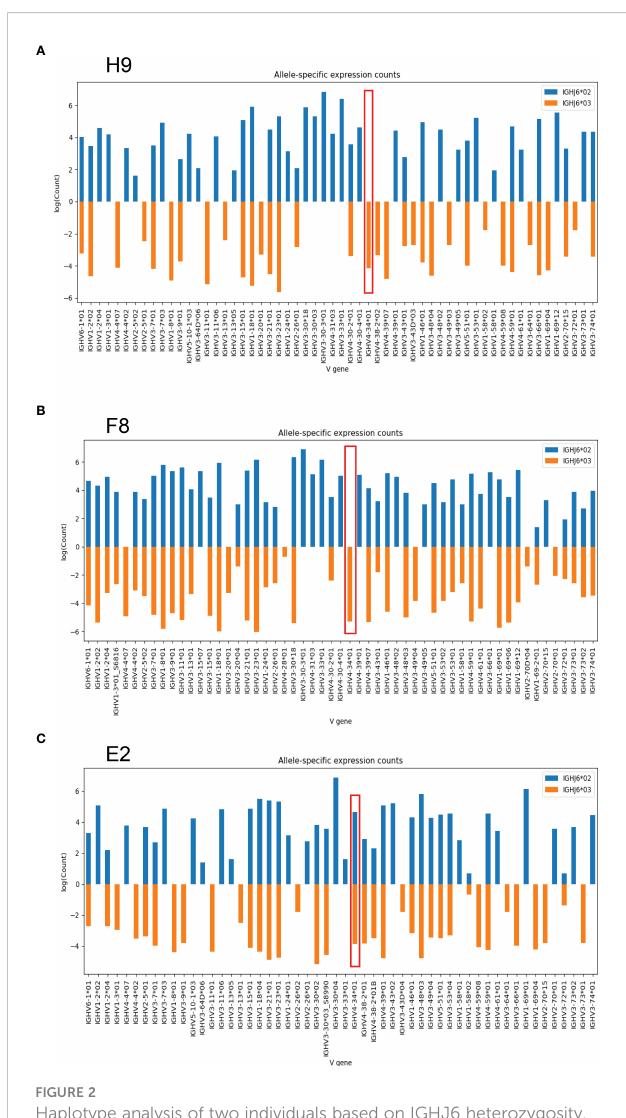
FIGURE 2 Haplotype analysis of two individuals based on IGHJ6 heterozygosity. (A) J6-anchored haplotype analysis of individual H9 reveals IGHV4-34 hemizygosity (red box). (B) J6-anchored haplotype analysis of individual F8 reveals IGHV4-34 hemizygosity (red box). (C) Reference haplotype from individual E2 reveals IGHV4-34